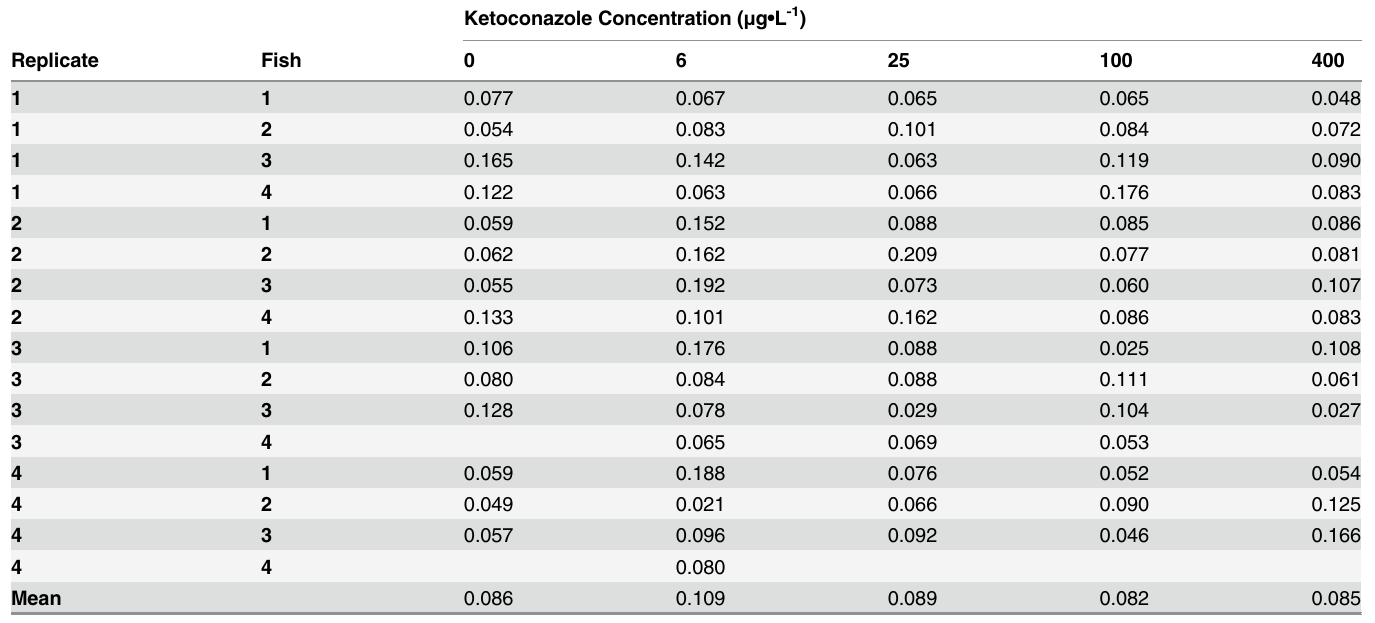
Table 2. Measured plasma VTG concentrations (nmol (cid:129) μ L -1 ) a in fathead minnows exposed to ketoconazole for 21 days. Ketoconazole Concentration ( μ g (cid:129) L -1